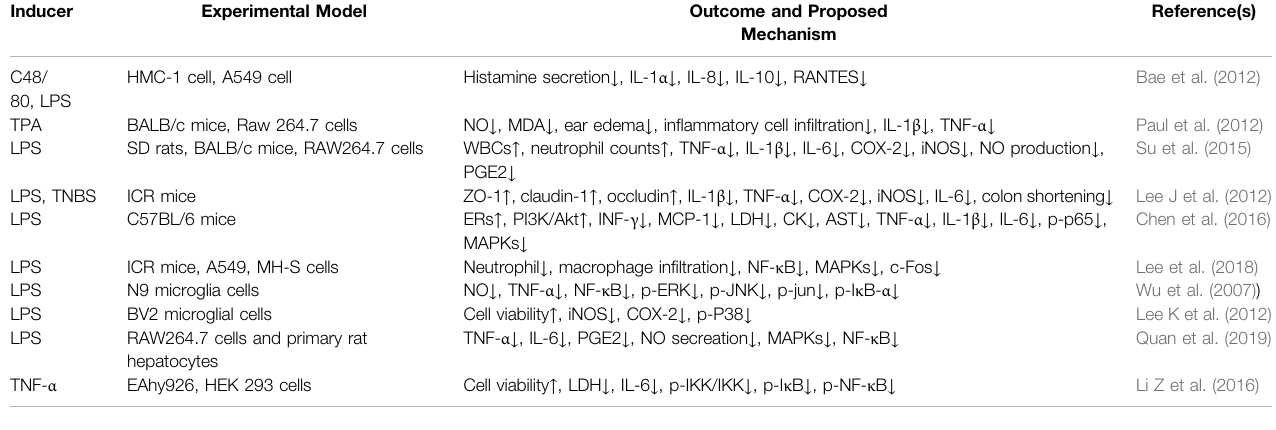
TABLE 3 | Summary of anti-in fl ammation effects of Re. Inducer